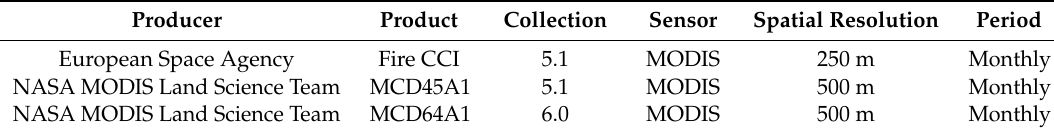
Table 1. Overview of burned area products selected for agreement